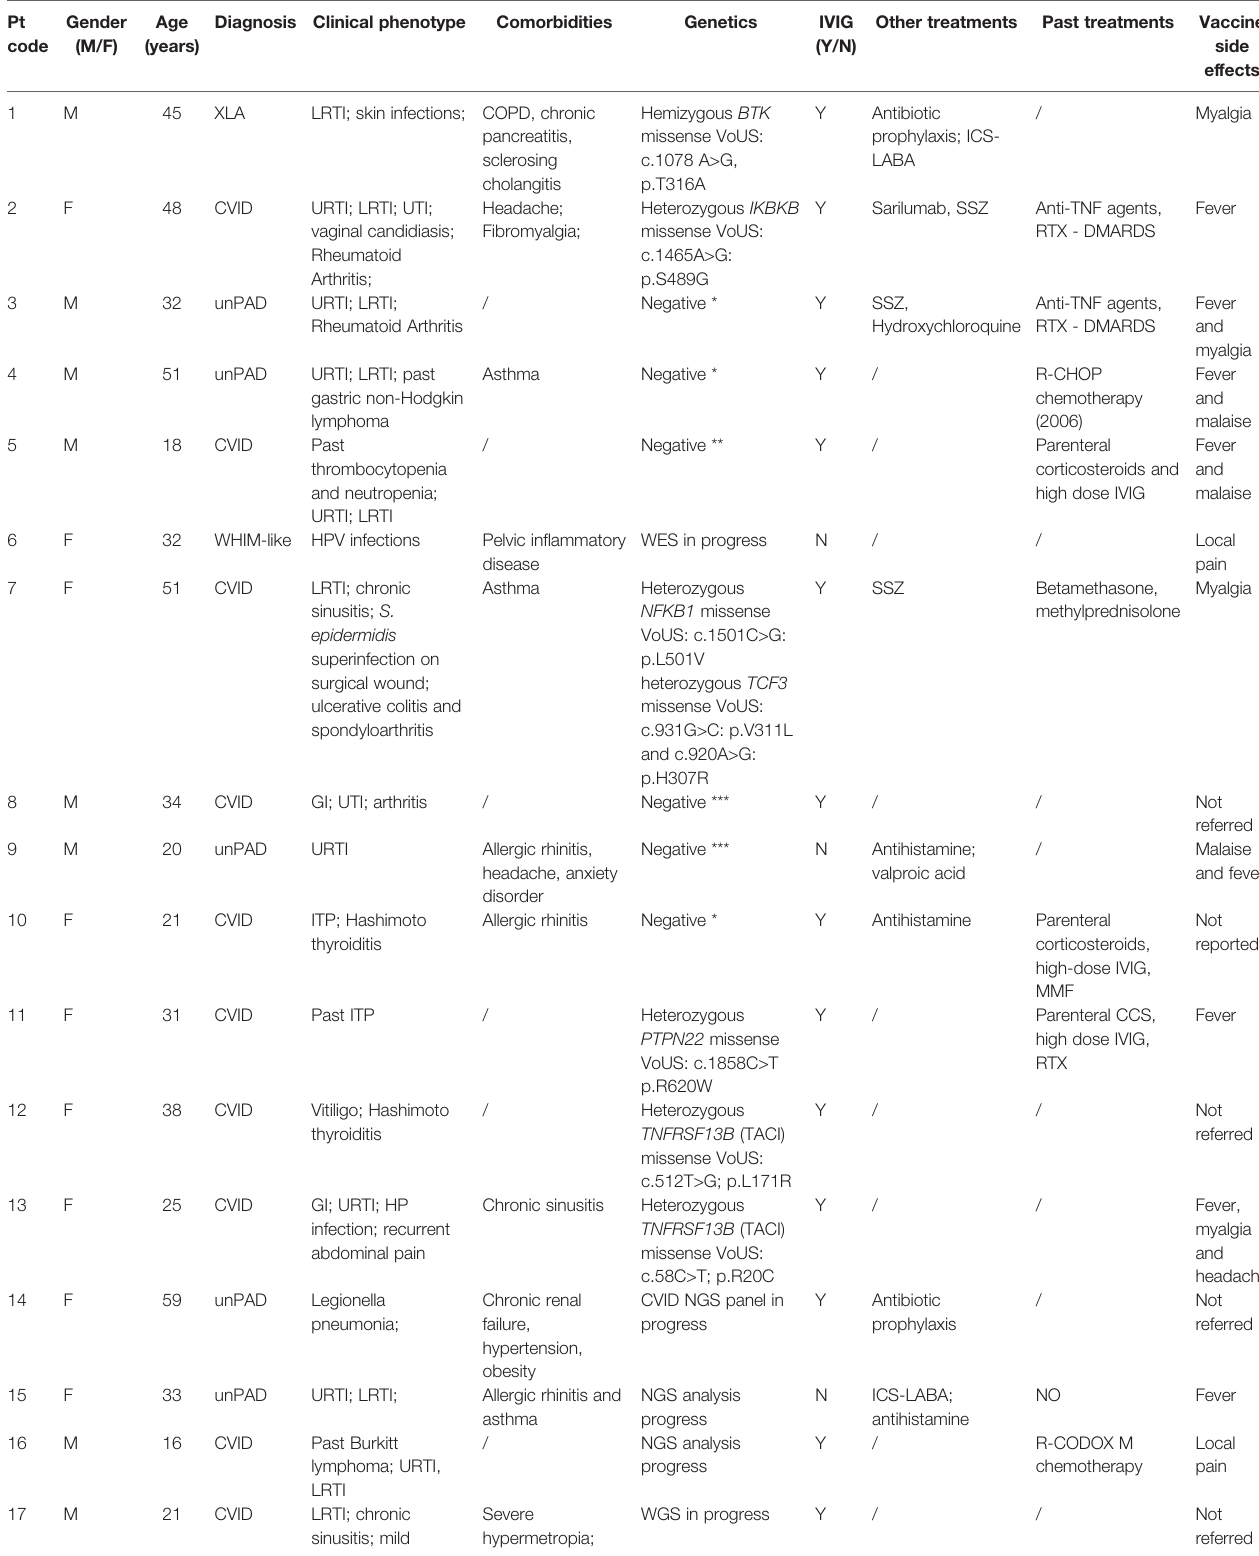
TABLE 1 | Demographics, diagnosis, and clinical and genetic data of IEI cohort. Pt Gender Age Diagnosis Clinical code (M/F) (years)